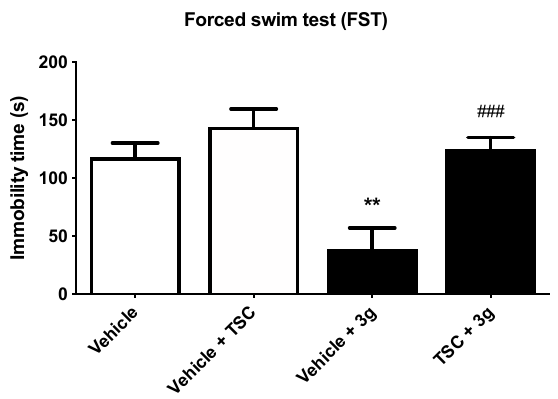
Figure 7. Effects of compound 3g (50 mg/kg) on the immobility time in the TSC-treated mice in the FST. Eight animals were used for each group. ** p < 0.01 compared to the vehicle group; ### p < 0.001 compared to the vehicle + 3g